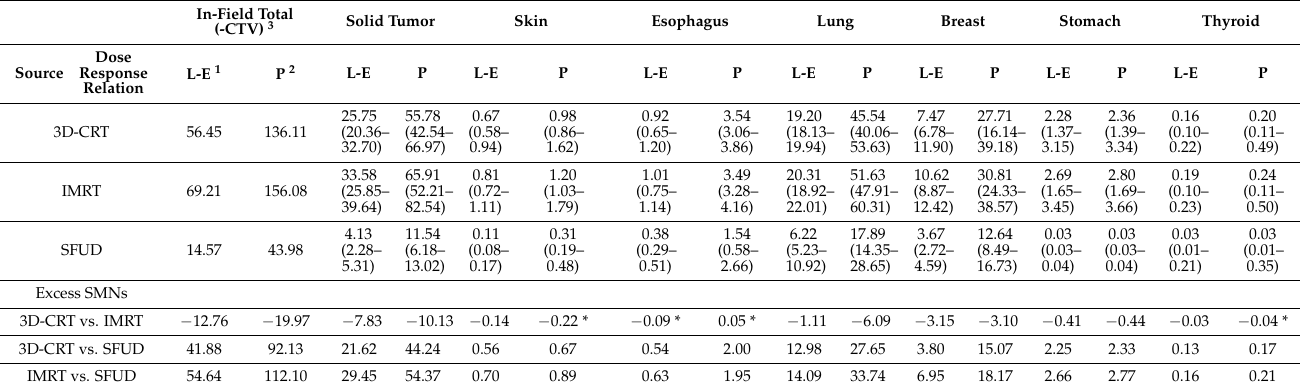
Table 5. Cancer risks (excess absolute risk given in /10,000 patients/year/Gy). Median values and the values of the first and third quartile are also presented.